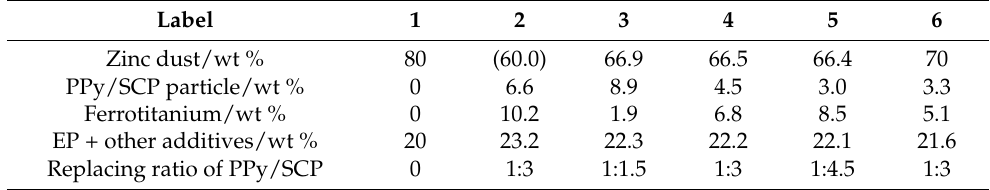
Table 2. The mass fraction of ZRP/PPy/SCP coating system through equal volume substitution.